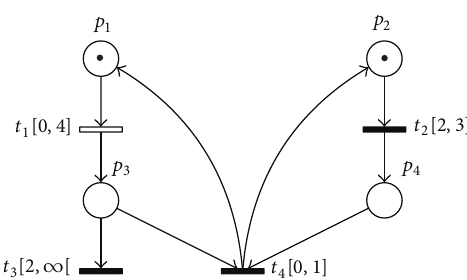
Figure 1: A simple Petri net with 𝑇 𝑐 = {𝑡 1 } .